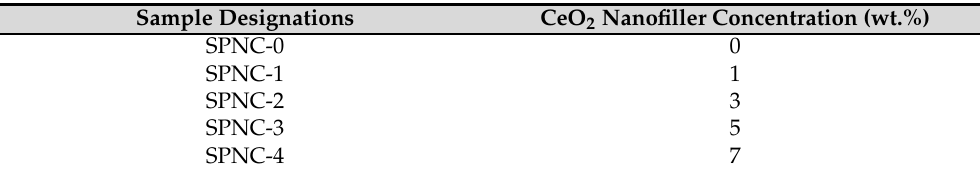
Table 1. Sample designation and CeO 2 concentration in the prepared poly (vinyl alcohol) (PVA)-based nanocomposites